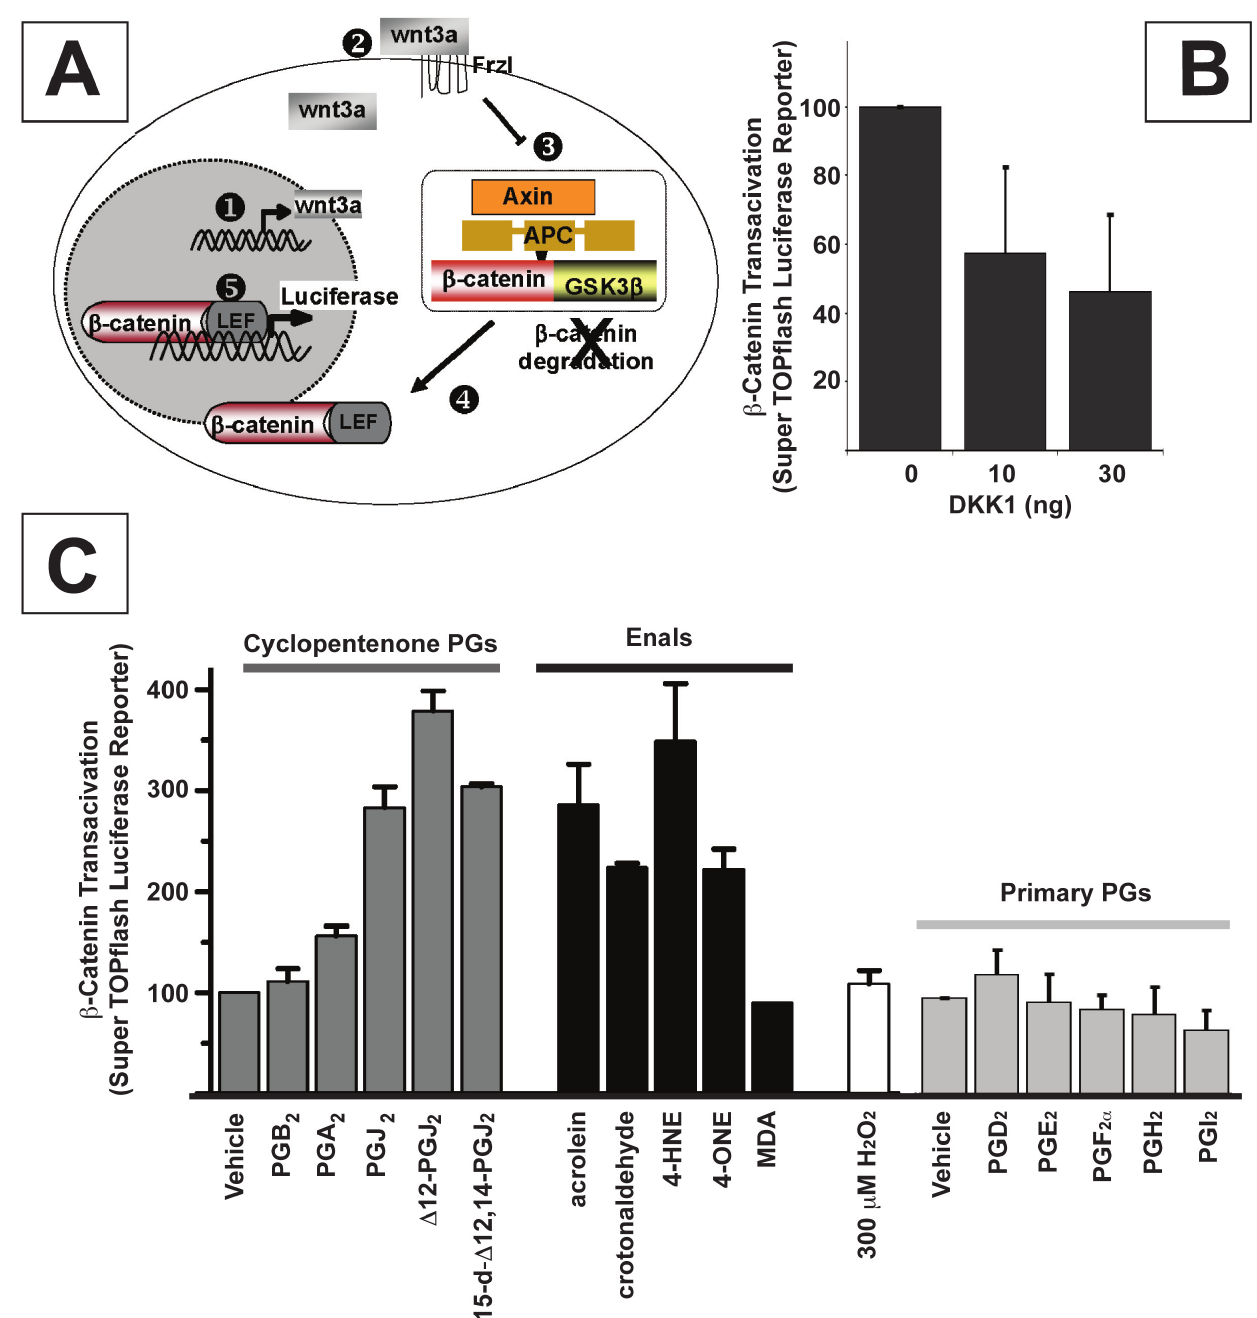
Figure 5. a , ß–unsaturated carbonyls enhance nuclear b -catenin signaling in STF3A cells: structure activity relationships. ( A ) STF3A cells harbor a stably integrated transgene which expresses WNT3A ( 1 ). When secreted, WNT3A elicits autocrine/paracrine stimulation of Fzl receptors ( 2 ) which inhibits APC-dependent turnover of b -catenin ( 3 ). If b -catenin is not phosphorylated by GSK3 b , it can accumulate as a b -catenin:LEF dimer ( 4 ) and bind to promoters on stably integrated b -catenin:luciferase reporter gene (SuperTop Flash) ( 5 ). Luciferase activity in cell lysates is proportional to nuclear b -catenin signaling. ( B ) Nuclear b -catenin signaling (luciferase luminescence) in STF3A cells (2 6 10 4 cells/well) grown for 24 hrs in medium containing 0, 10, or 30 ng/ml of DKK1 (mean + s.d., n=3). DKK1, a wnt antagonist, inhibited b -catenin signaling ( C ) Nuclear b - catenin signaling in STF3A cells (2 6 10 4 cells/well) grown for 24 hrs in medium containing 20 m M of cyPGs; a , b -enals or primary PGs. Several reactive electrophiles enhanced b -catenin signaling by , 2–4 fold. Histogram represents the mean + s.e.m., n=4.